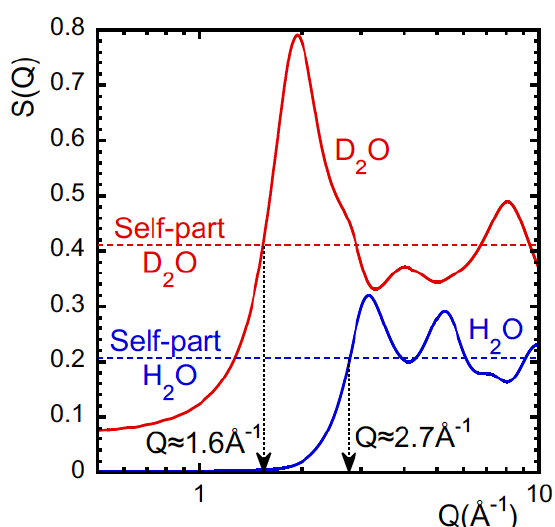
Fig. 7. Static structure factor S ( Q ) calculated from the simulations for both D 0 O and H 0 O. The corresponding self part is indicated by the dotted line in each case. The vertical arrows mark the Q -value at which the self-part equals S ( Q ) in each case. At this Q -value, the corresponding distinct part is zero, thereby crossing over from negative to positive